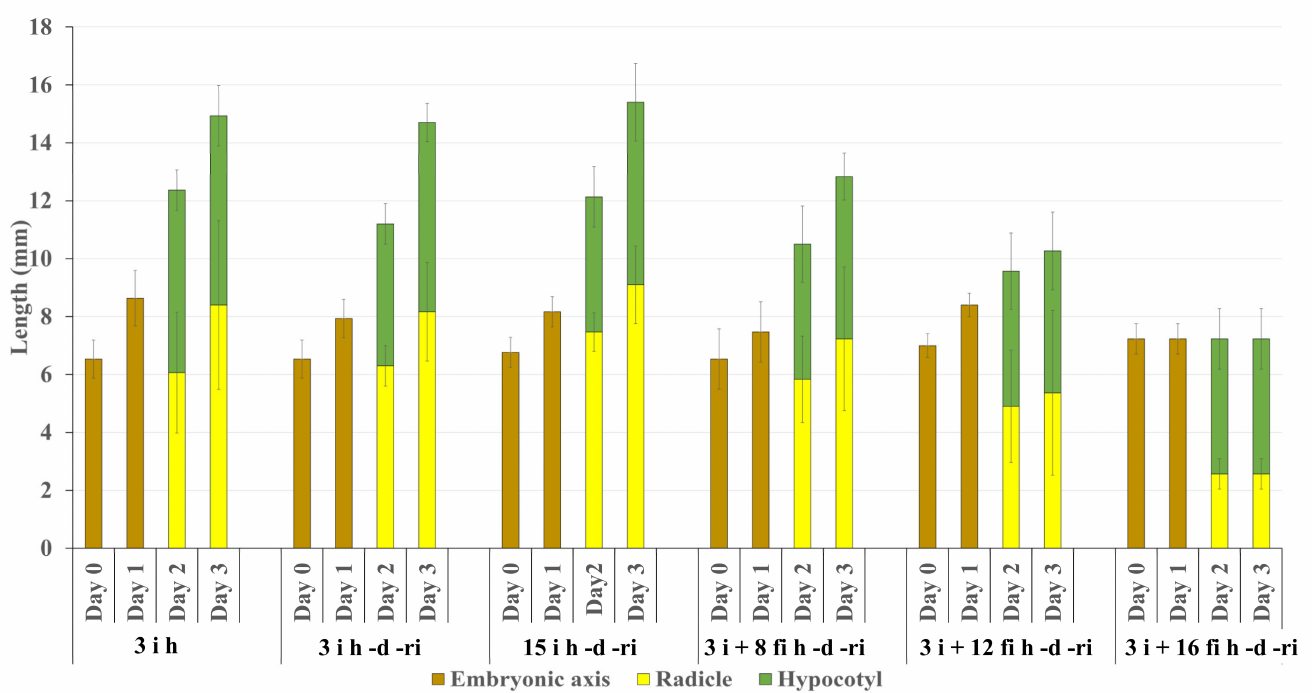
Figure 4. Growth of soybean embryonic axes, hypocotyls, and radicles during 3 days after re- imbibition ( ri ) following 24 h desiccation ( d ). Embryonic axes were excised after 3 h and 15 h imbibition ( i ) of seeds or kept on wet filter paper ( fi ) for an extra 8 h, 12 h, and 16 h after excision from 3 h imbibed ( i ) seeds. As a control, growth of embryonic axes excised after 3 h imbibition and kept on wet filter paper without desiccation is shown at the left. Bars represent the standard deviation